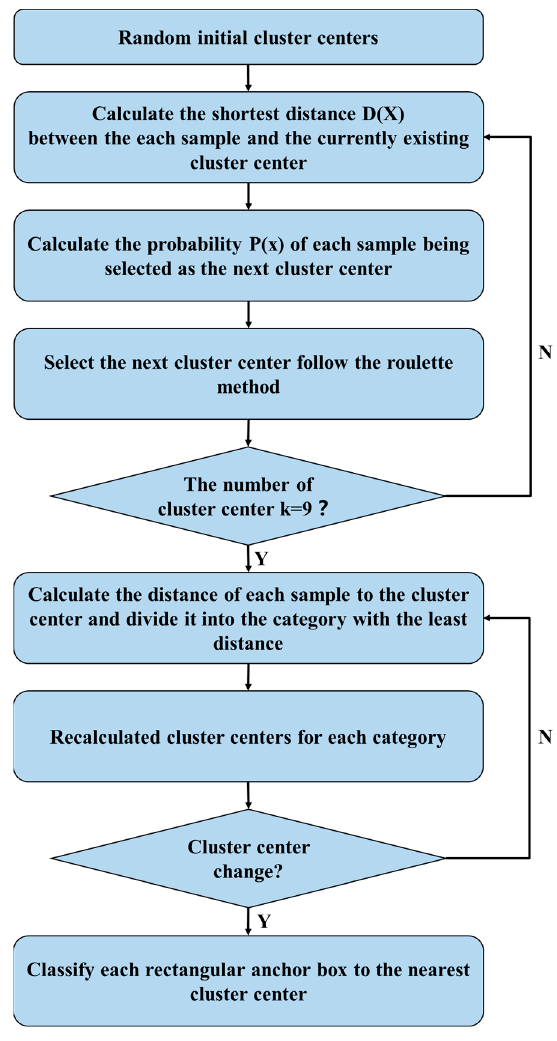
Figure 2. K-Means++ clustering algorithm.